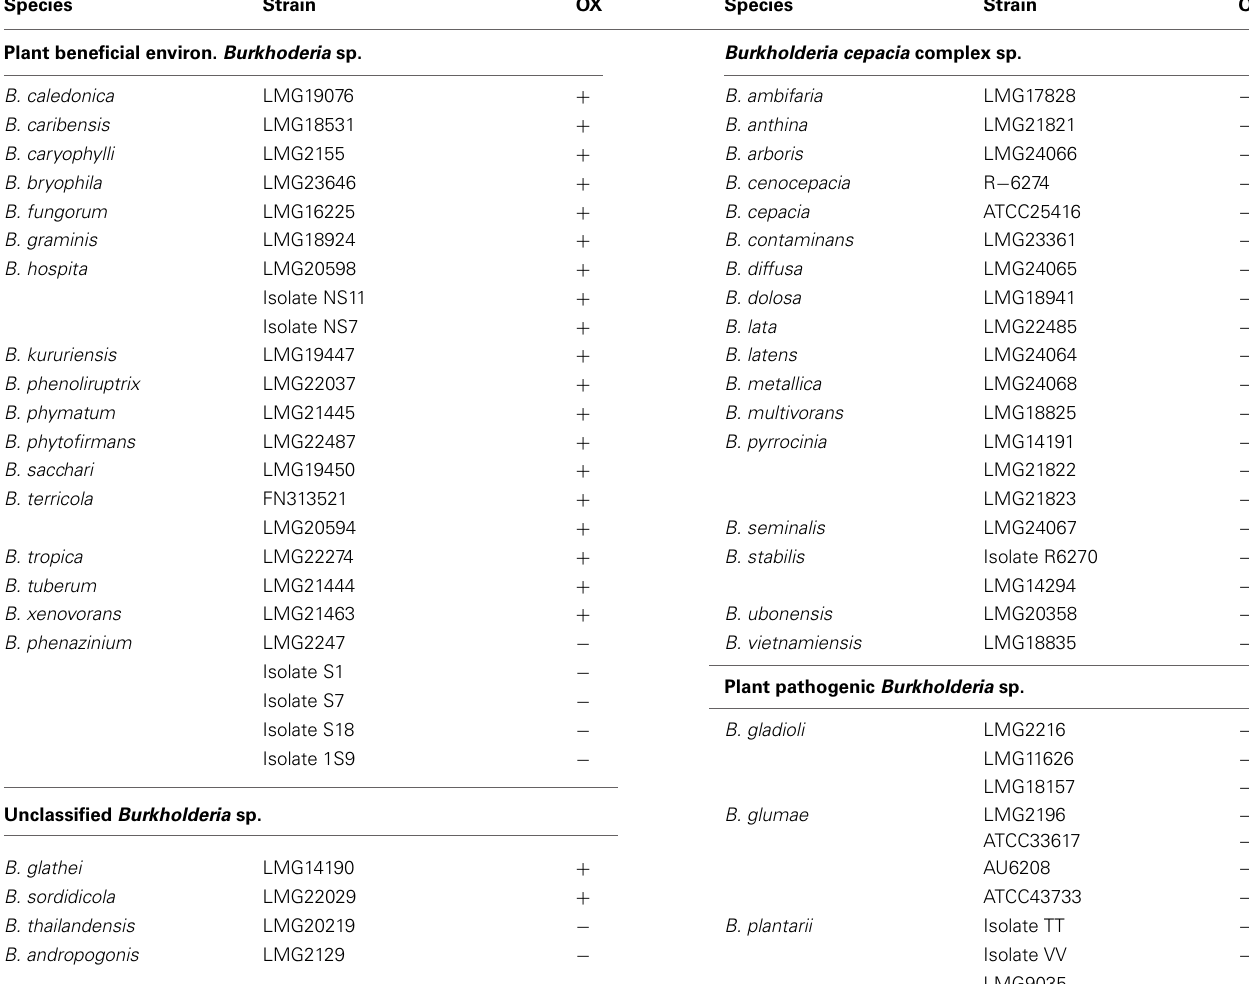
Table 1 | Oxalate degradation ability (OX) in various species of the Burkholderia genus. Species Strain OX Species Strain OX Plant beneficial environ. Burkhoderia